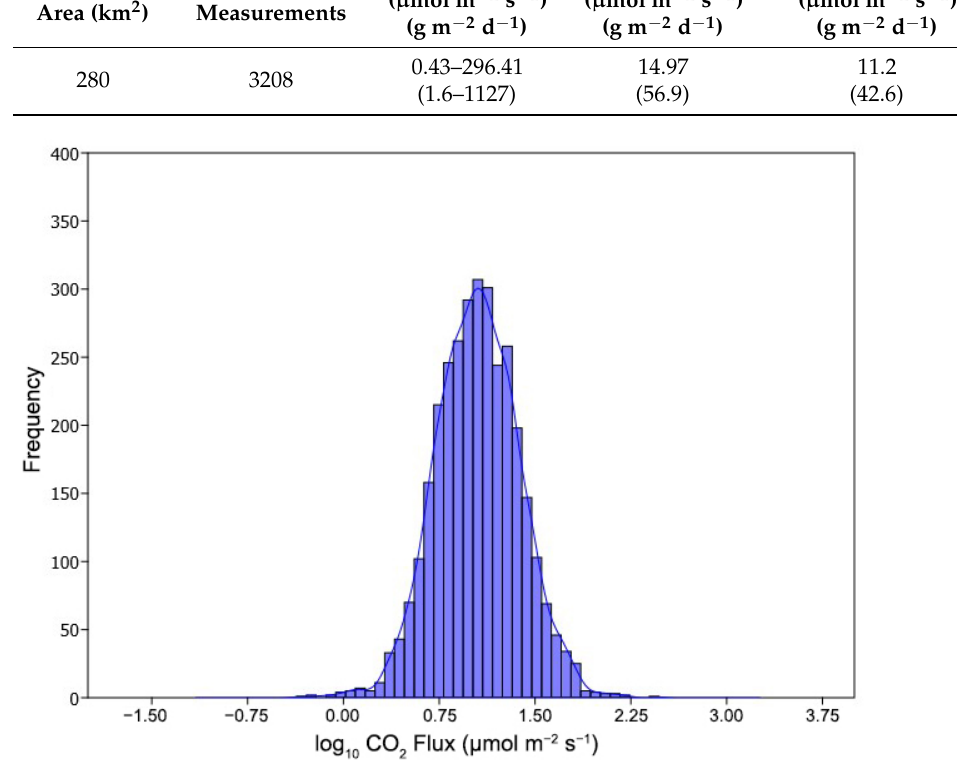
Figure 3. Frequency plot of soil CO 2 flux measurements. Range from 0.43 up to 296.41 µ mol m − 2 s − 1 corresponds to − 0.37 to 2.47 log 10 CO 2 flux values.